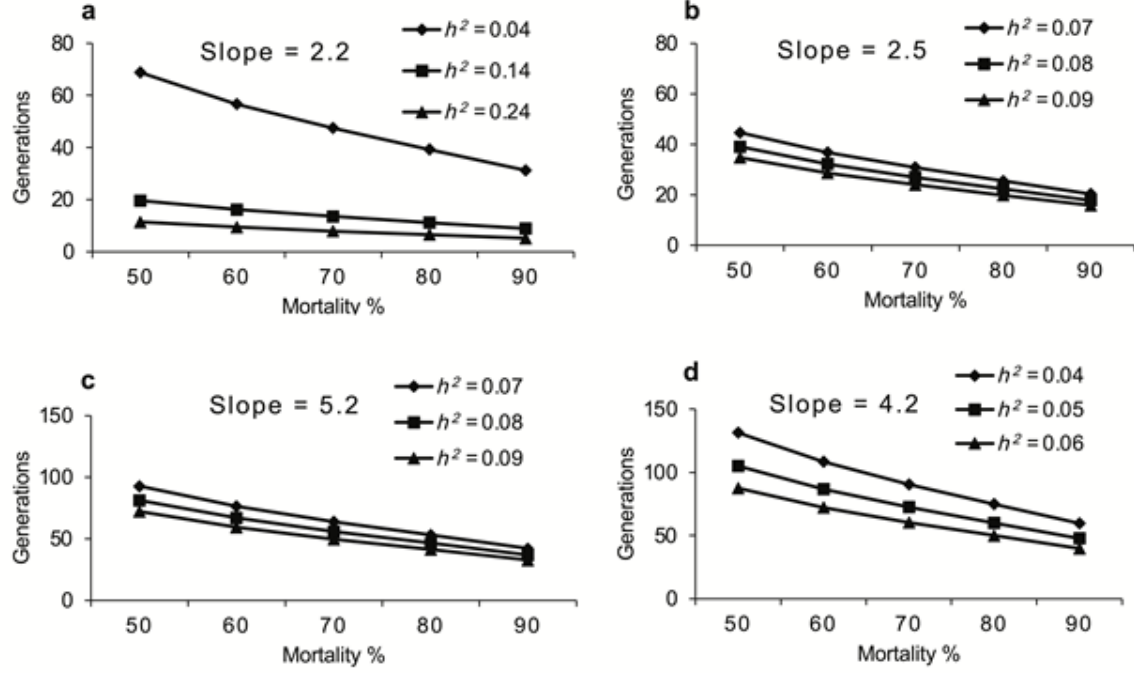
Figure 3. Effect of realized heritability on number of generations of D. suzukii required for a 10-fold increase in LC 50 of female exposed to spinosad ( a ), male exposed to spinosad ( b ), female exposed to malathion ( c ) and male exposed to malathion ( d ) at different selection intensities (i).